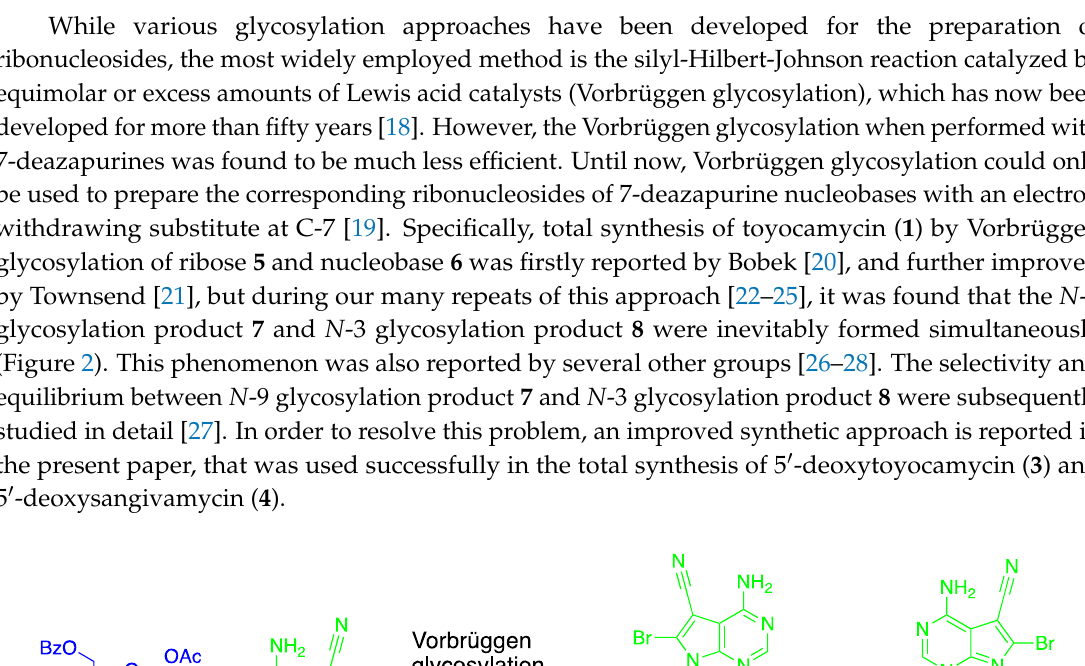
Figure 1. Examples of naturally occurring 7-deazapurine nucleosides.